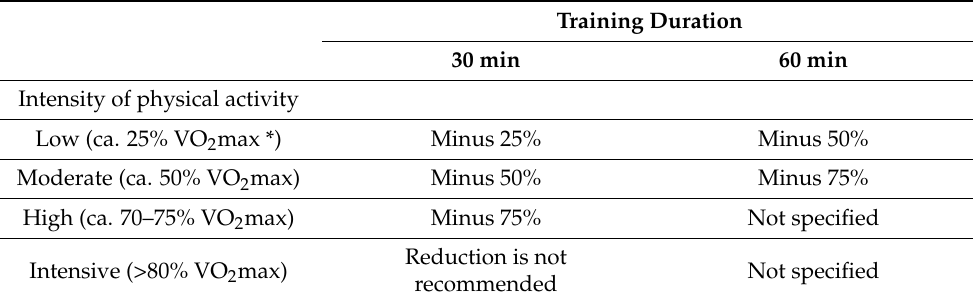
Table 2. Adjustments of meal insulin bolus rates depending on training duration and intensity according to ADA recommendations